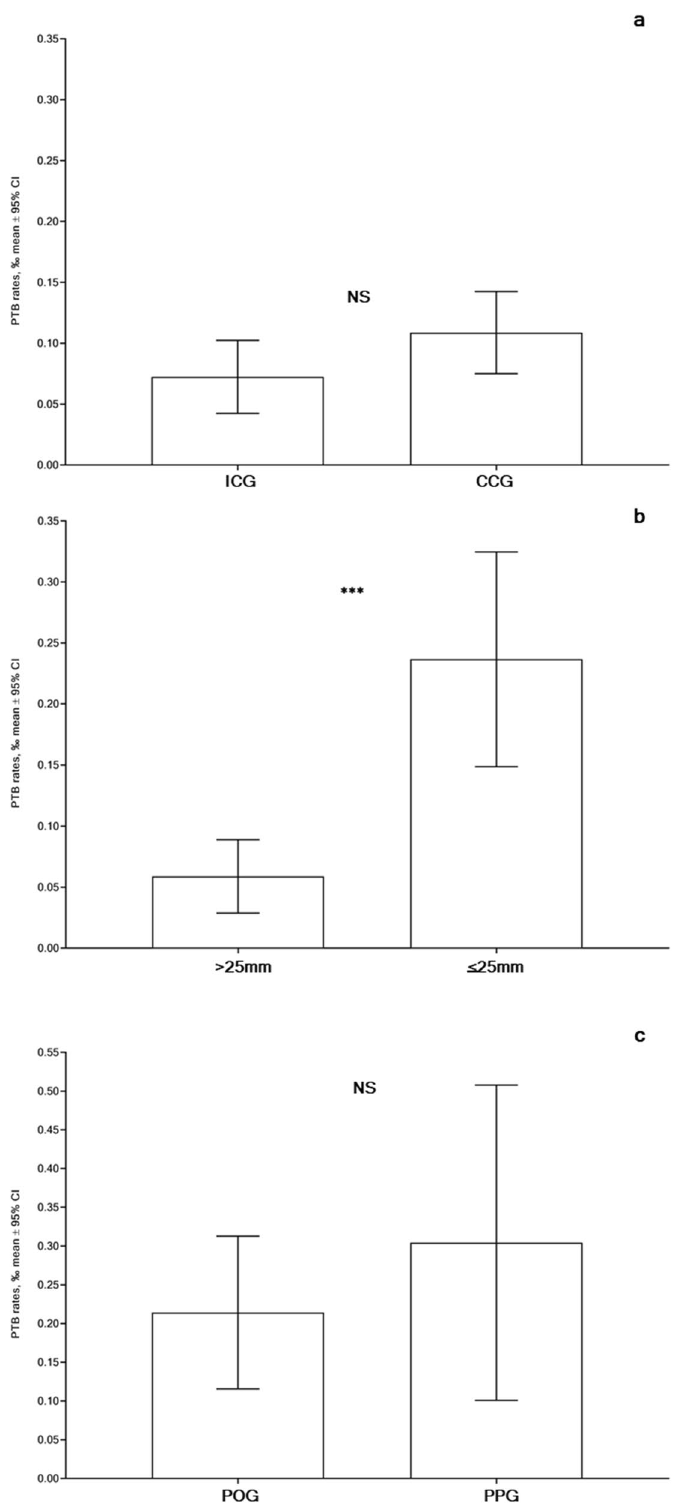
Figure 8. Preterm birth (PTB) rates (unit: %) in asymptomatic women with singleton pregnancies: ( a ) Intact Cervix (ICG) vs. Cervical Conization (CCG), groups; ( b ) Adequate cervical length (CL > 25 mm) vs Short cervix (CL ≤ 25 mm), groups; ( c ) Progesterone-only (POG) vs Progesterone-Pessary (PPG), groups. p-values were achieved using Mann–Whitney two-tailed t-test with Alpha =